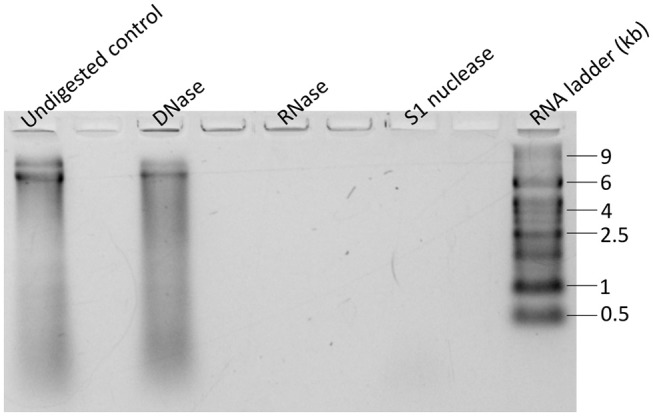
Nucleic acids type of GdelRNAV-01 after extraction. Extracts were treated with DNase treatment, with RNase treatment, or with S1 nuclease treatment.